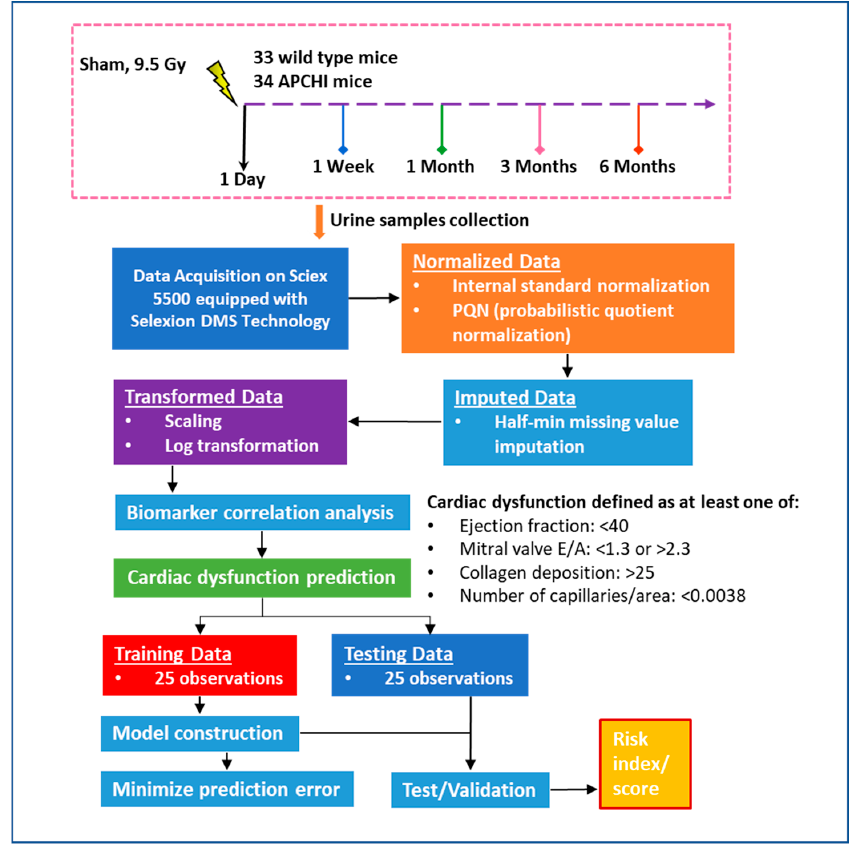
Figure 1. Flowchart outlines the framework of our metabolomics-based biomarker study aimed at predicting radiation-induced heart dysfunction. We utilized a cohort of 33 wild type mice and 34 APCHi mice, which included both irradiated and sham mice. Out of the 50 mice exposed to radiation and evaluated for cardiac dysfunction outcomes, 18 mice had normal results while 32 mice showed signs of cardiac dysfunction. Models were developed using a training dataset of 25 mice, and the test dataset of 25 mice was used to calculate the AUC and evaluate the risk score for radiation-induced heart injury.